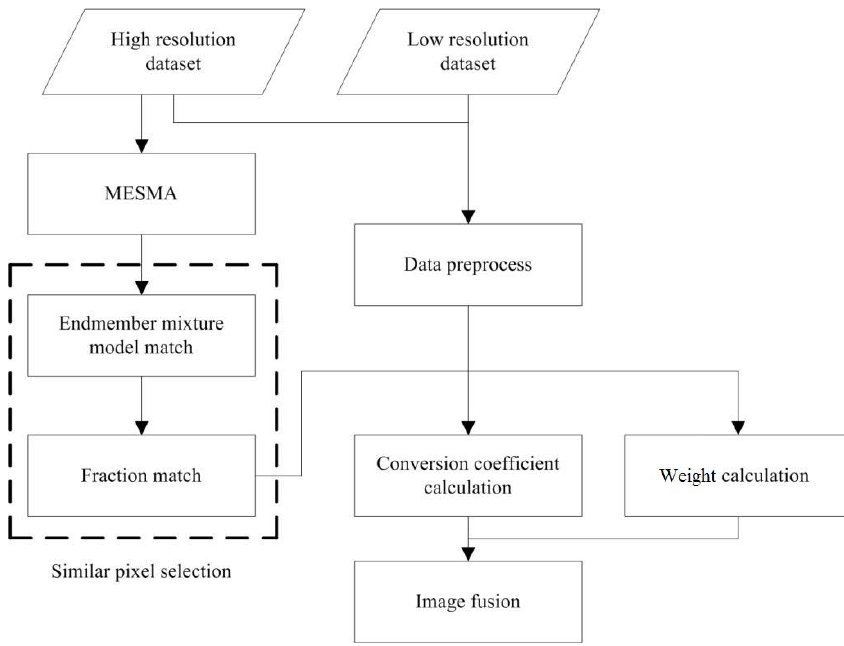
Figure 1. The flowchart of the Improved ESTARFM.